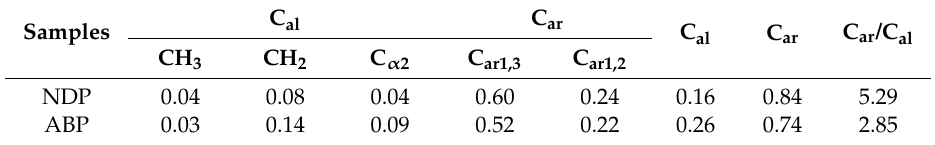
Table 2. Normalized integration data based on the 13 C NMR spectra.